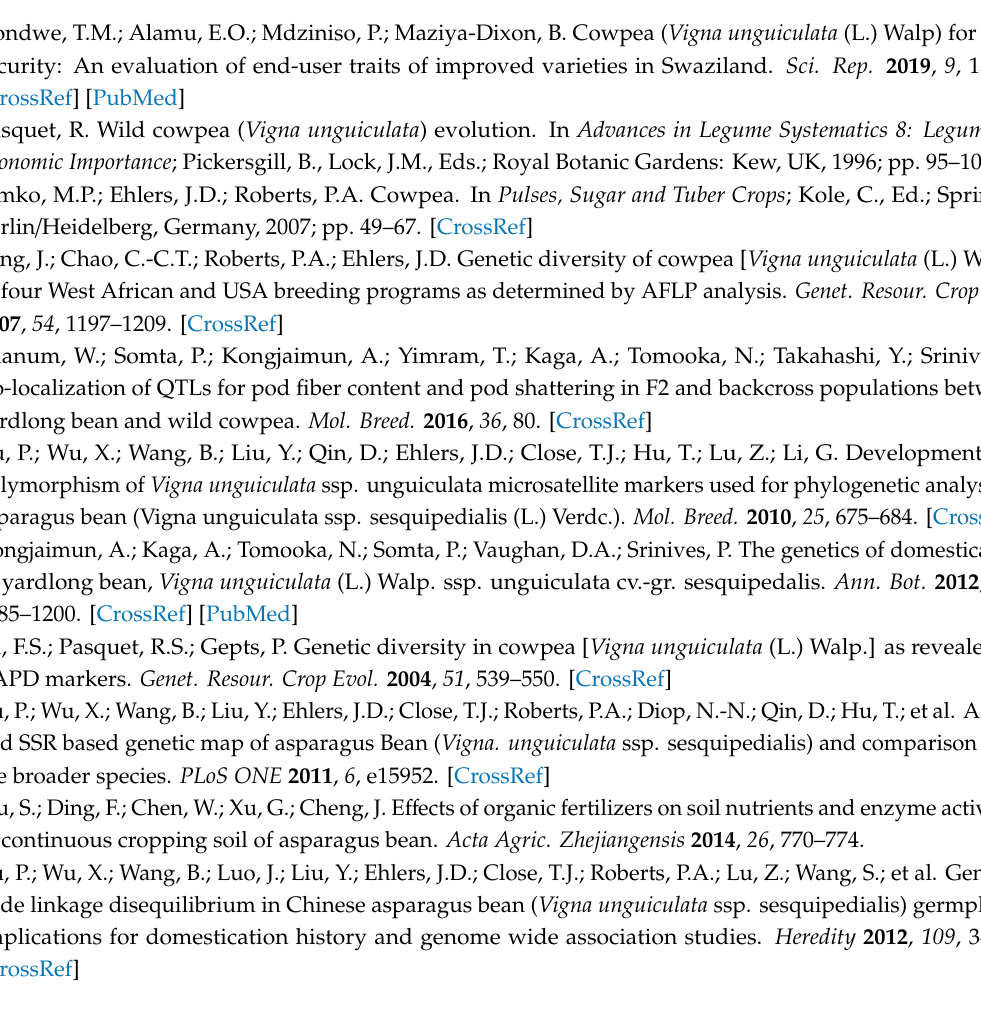
Figure S1: A diagram depicting development of mapping populations (F2A, F2B and F2C) used in this study. Figure S2: Frequency distribution of pod fiber content (hemicellulose (A), cellulose (B) and lignin (C)) and pod shattering (D) in F2A population (F 2:3 generation) of the JP81610 × TVnu-457. Figures are drawn using data from the study of Suanum et al. [5] with permission from Springer Nature. Table S1: Marker genotypes of 28 F 2 plants of F2B population (JP81610 x TVnu-457) selected for generating F2C population (F 2:3 generation). A, B, H and—represent JP81610 genotype, TVnu-457 genotype, heterozygous and missing data, respectively. Table S2: Characteristics of DNA markers used in this